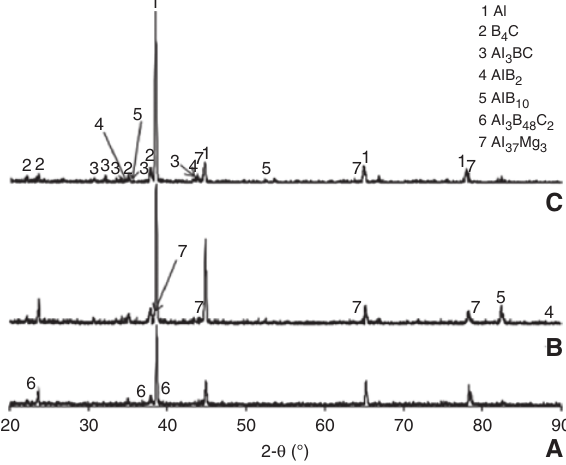
Figure 2: XRD patterns of (A) S1, (B) S3 and (C) S4 alloy matrix composites.